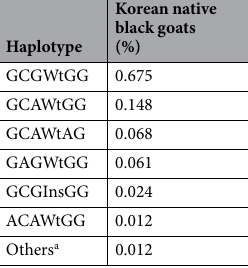
Table 3. Haplotype frequencies of 6 SPRN polymorphisms in Korean native black goats. a Others contain rare haplotypes with frequency <